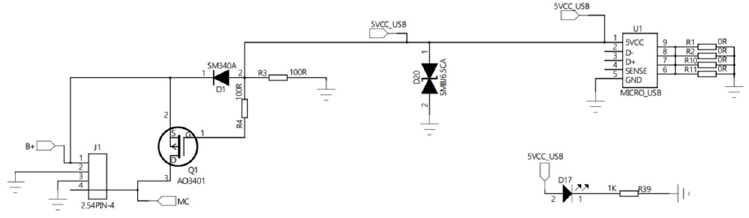
Figure 6. Schematic diagram of the power supply module.